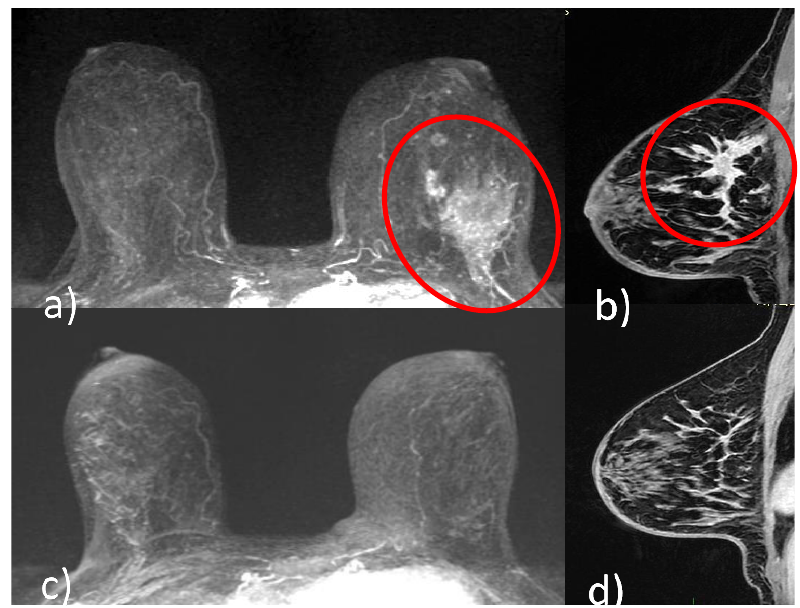
Figure 1. A 51-year-old patient with invasive ductal carcinoma (ER 40% PR 3% Ki67 40% HER2 3+) of the upper outer quadrant of the left breast. Pre-NACT CE-MRI revealed an area of non-mass enhancement with segmental distribution in the left breast that extends to pectoralis muscle without signs of invasion (red circle, ( a ) axial maximum intensity projection reconstruction image; red circle, ( b ), sagittal post-contrast T1-weighted image). At the end of NACT, CE-MRI showed no residual tumor (pCR) (( c ) axial maximum intensity projection reconstruction image; ( d ) sagittal post-contrast T1-weighted image).